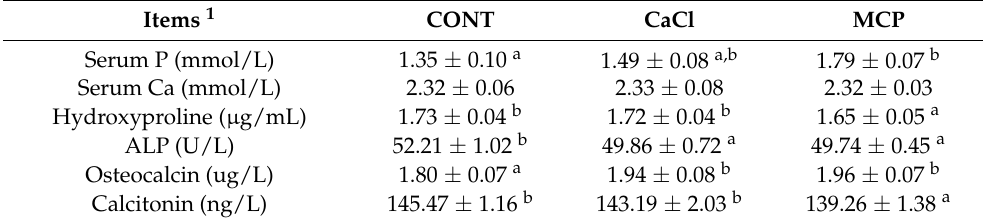
Table 3. Effects of calcium (Ca) and phosphorus (P) supplementation on serum parameters of yak heifers (mean ± SD).